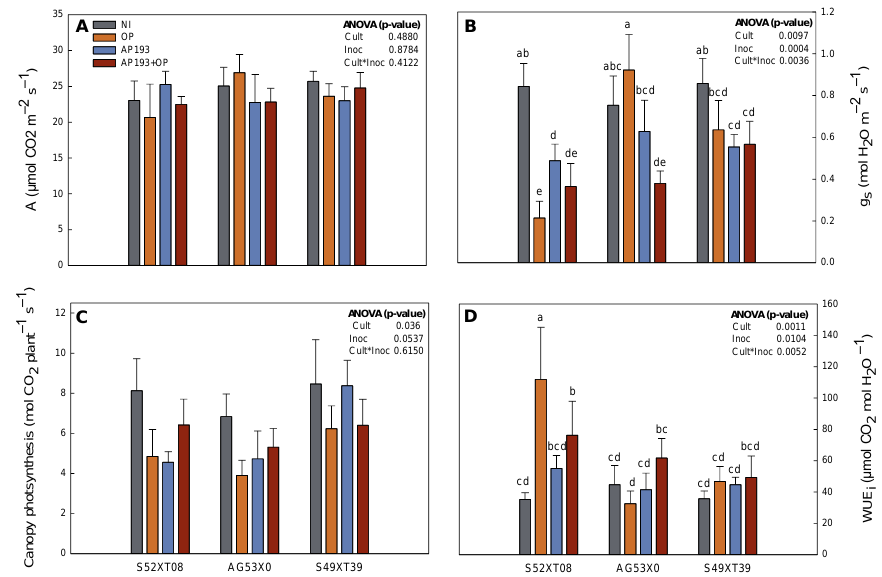
Figure 1. Photosynthesis rate (A, A ), stomatal conductance (g s , B ), canopy photosynthesis ( C ) and intrinsiceffective water-use efficiency (WUEi, D ) measured at R4 for three soybeans cultivars (AG53X0, S49XT39, S52XT08) grown in the greenhouse with four different inoculations: Non-inoc- ulated control (NI), orange peel alone (OP), Bacillus velezensis strain AP193 alone (AP193), and the combination of Bacillus velezensis strain AP193 and orange peel (AP193+OP). Bars represent the standard error for each treatment. Different letters between g s and WUEi represent treatments that were statistically different ( p -value < 0.05). For canopy photosynthesis, the control treatment had higher flux (29.1%) compared with the AP193 plus OP inoculation. 3.3. Field Experiment to Test the Response of Inoculation with PGPR plus Orange Peel Amendment on Contrasting Soybean Cultivars A cultivar effect was observed for plant height at both E.V. Smith (EVS) and Tennes- see Valley (TV) locations (Figure 2). However, there was no effect of inoculation or the interaction between variables for the plant growth parameters measured. The inoculation with AP193 resulted in higher biomass accumulation (6.1%) at EVS, while at TV the OP was responsible for the highest value (5.1%) compared with the non-inoculated treatment. For plant height, plants maintained the same range on the treatments within cultivars. Cultivar AG53X0 had the total aboveground biomass (+4.2% at EVS and +20.9% at TV) and plant height (+1.6% at EVS and +3.8% at TV) increased with inoculation AP193+OP compared with the non-inoculated treatment at both locations. Therefore, this cultivar was observed to have more consistent positive results in comparison with the other culti- vars as some increased growth in one location and decreased it in